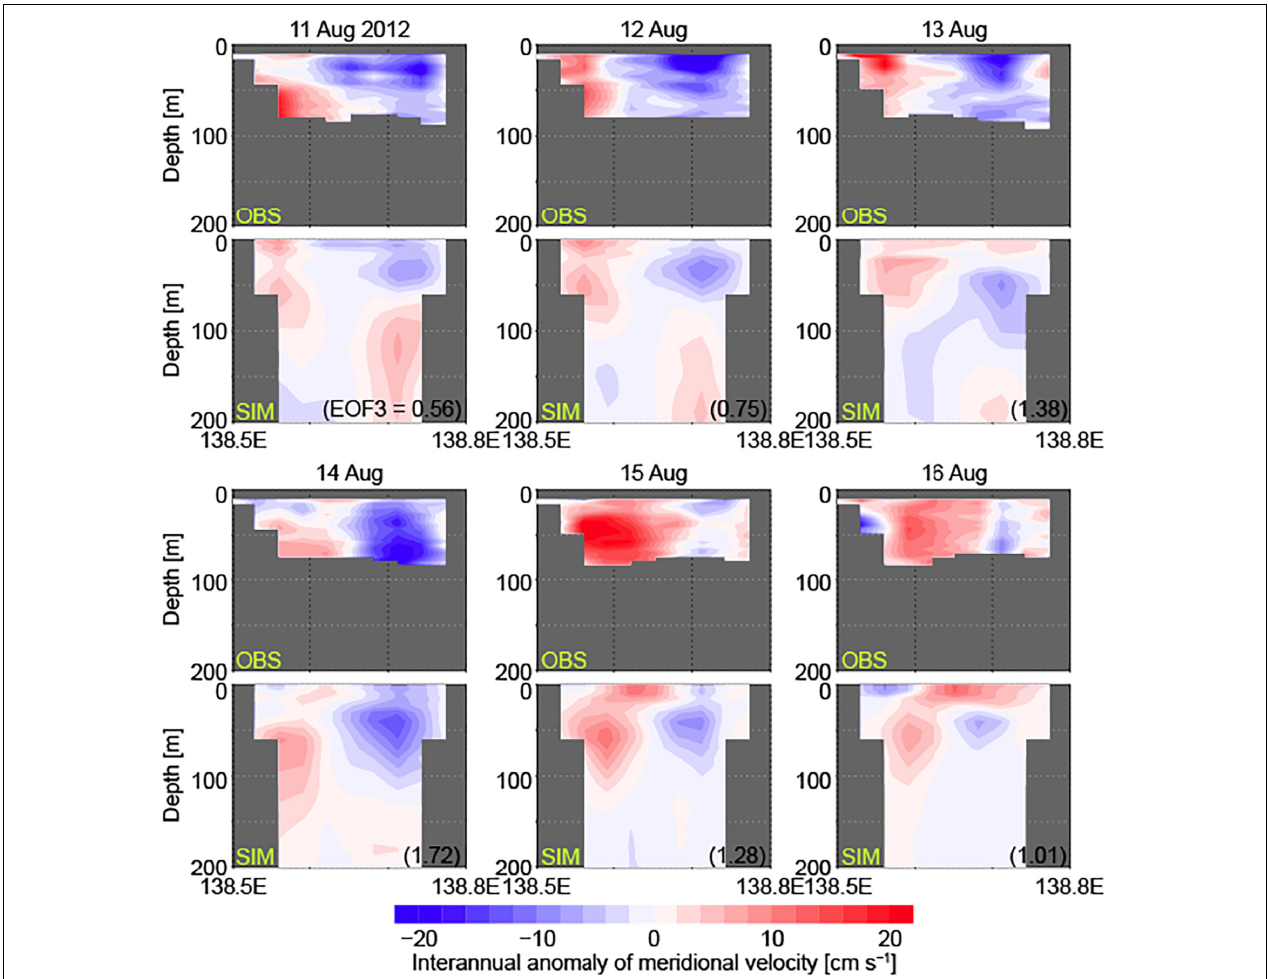
FIGURE 15 | Distributions of daily-mean interannual anomalies of meridional velocities on a cross section along the regular operation line of the sightseeing ferry Fuji (purple dashed line in Figure 14A ) between Shimizu Harbor (138.50 ◦ E, 35.01 ◦ N) and Toi Harbor (138.79 ◦ E, 34.91 ◦ N) during 11–16 August 2012. ADCP observation data (OBS; upper) and the simulation product (SIM; lower; with EOF3 time coefficient) are compared for each day. Missing values (due to observation limit and land cover) are indicated by gray